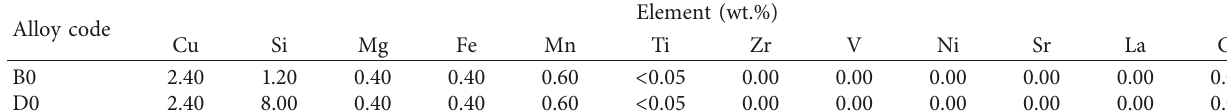
Table 1: Chemical composition of the two base alloys used in the present work. Alloy code